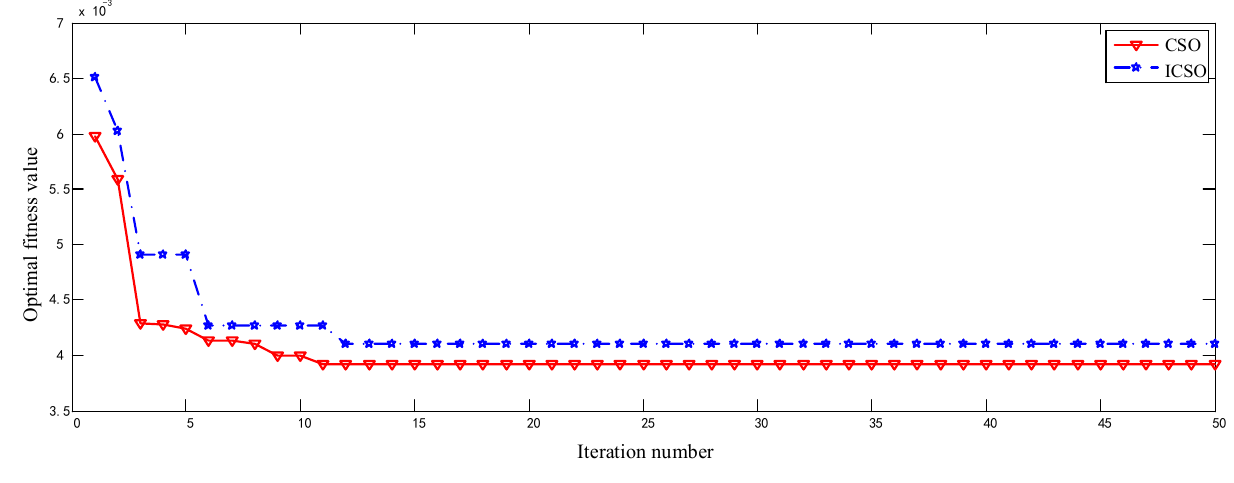
Figure 8. Optimization curve of dam model parameters.